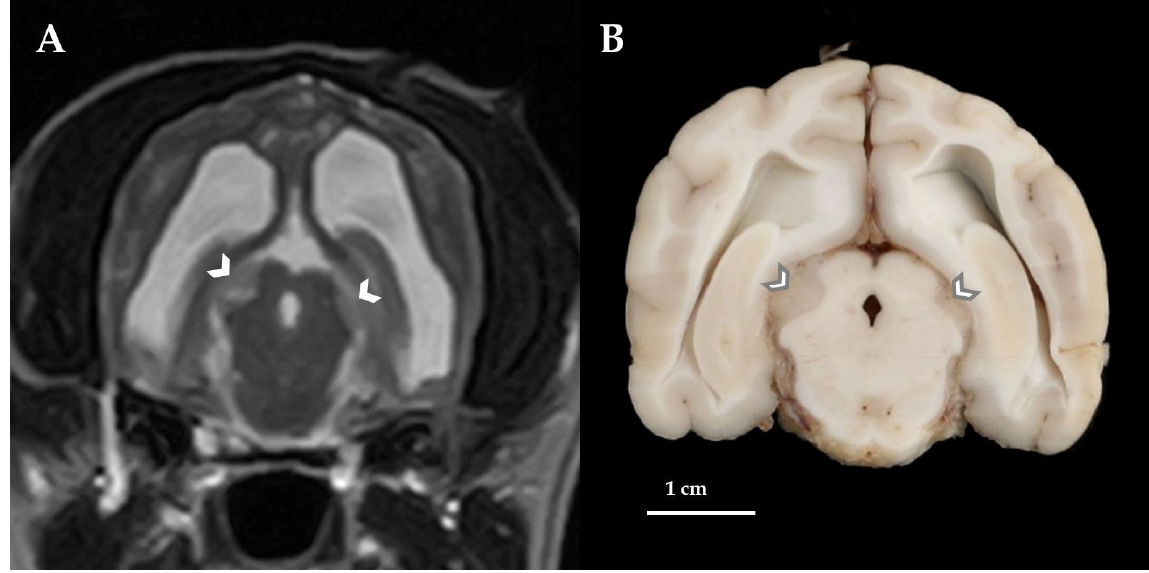
Figure 4. Post-mortem MRI, transverse T2W ( A ) and frontal brain section, formalin-fixed ( B ) of the dog’s brain at the level of the midbrain. Post-mortem MRI demonstrated a resolution of the SFA, a moderate hydrocephalus internus and an enlargement of the midbrain lesions (arrowheads, A ). On necropsy, the midbrain lesions revealed to be macroscopic tumor foci arising from the subarachnoid space (arrowheads, B ). The left side of the patient is on the right side of the